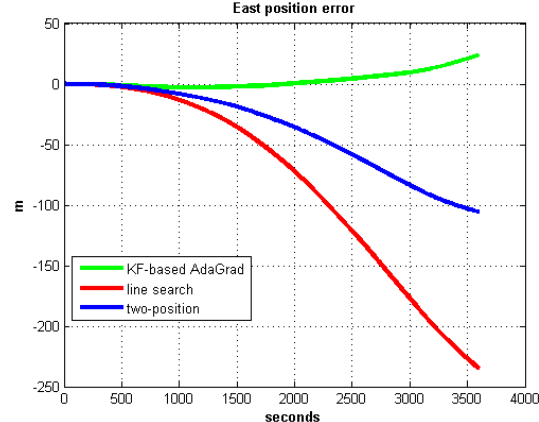
Figure 9. East position error.